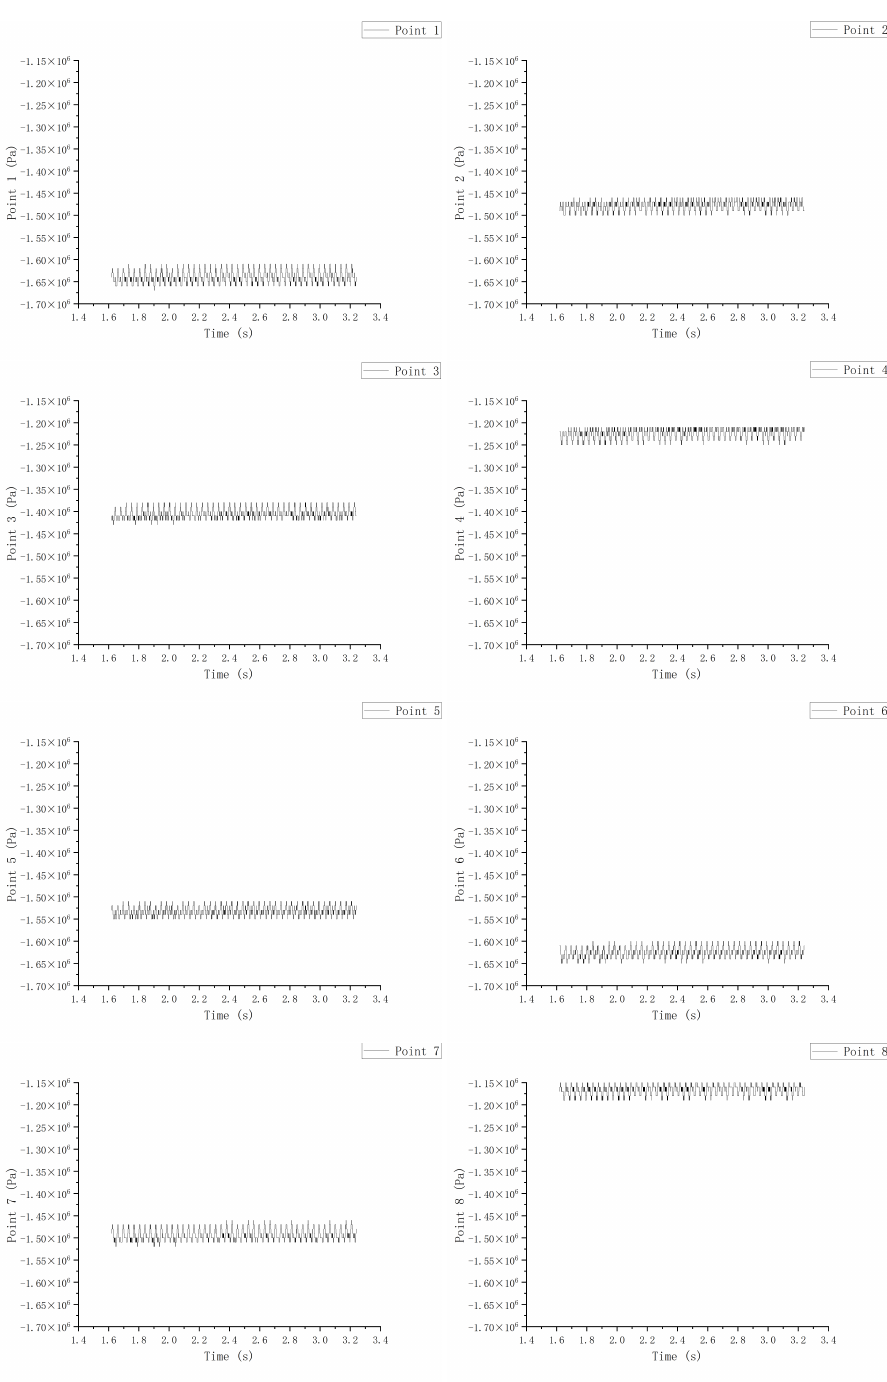
Figure 27. The pressure distributions of the lower bottom ring